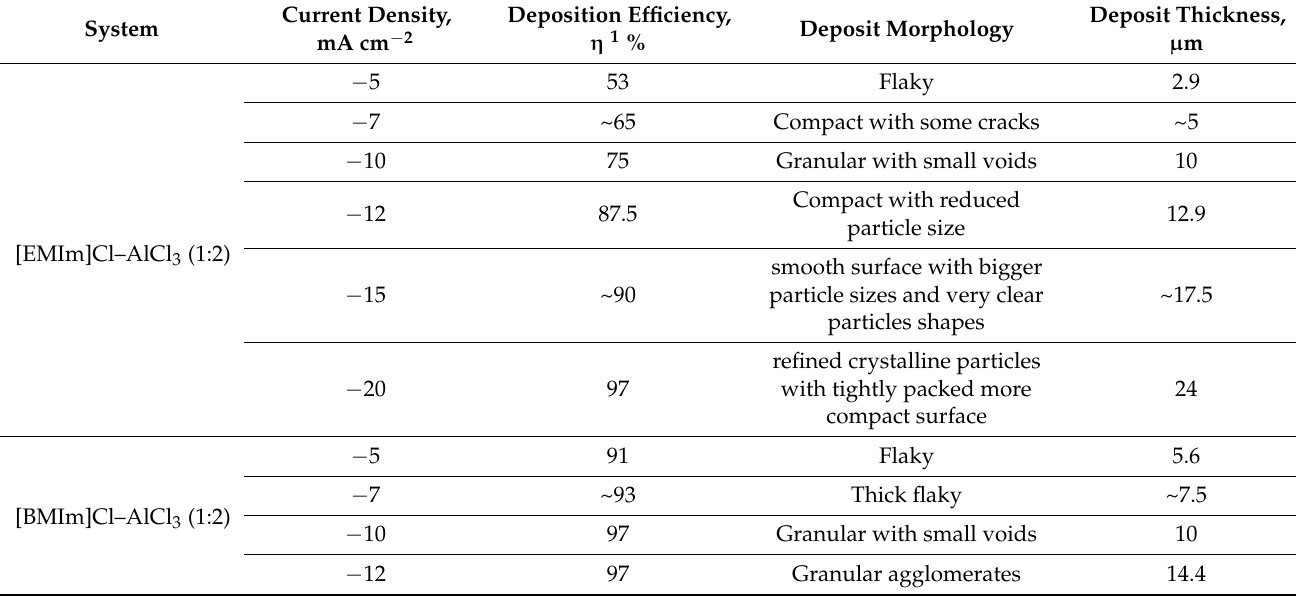
Table 5. Table comparing the deposit characteristics of Al deposits in [EMIm] and [BMIm]-based